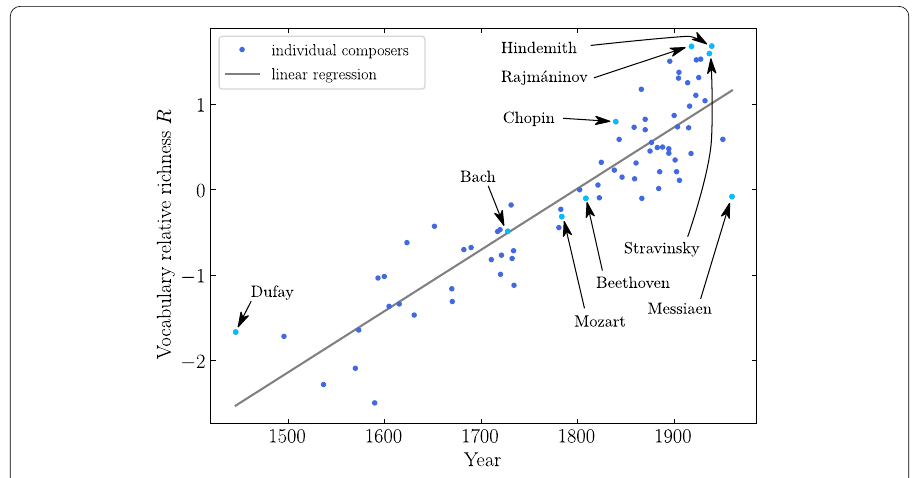
Figure 4 Vocabulary relative richness R for each composer in chronological order. Horizontal axis is birth +20+ death, divided by 2. The straight line is a linear regression with slope 0.72 ± 0.04 “units of richness” per century and a linear correlation coefficient ρ = 0.90 (and intercept –12.9). Some particular composers are highlighted, for the sake of